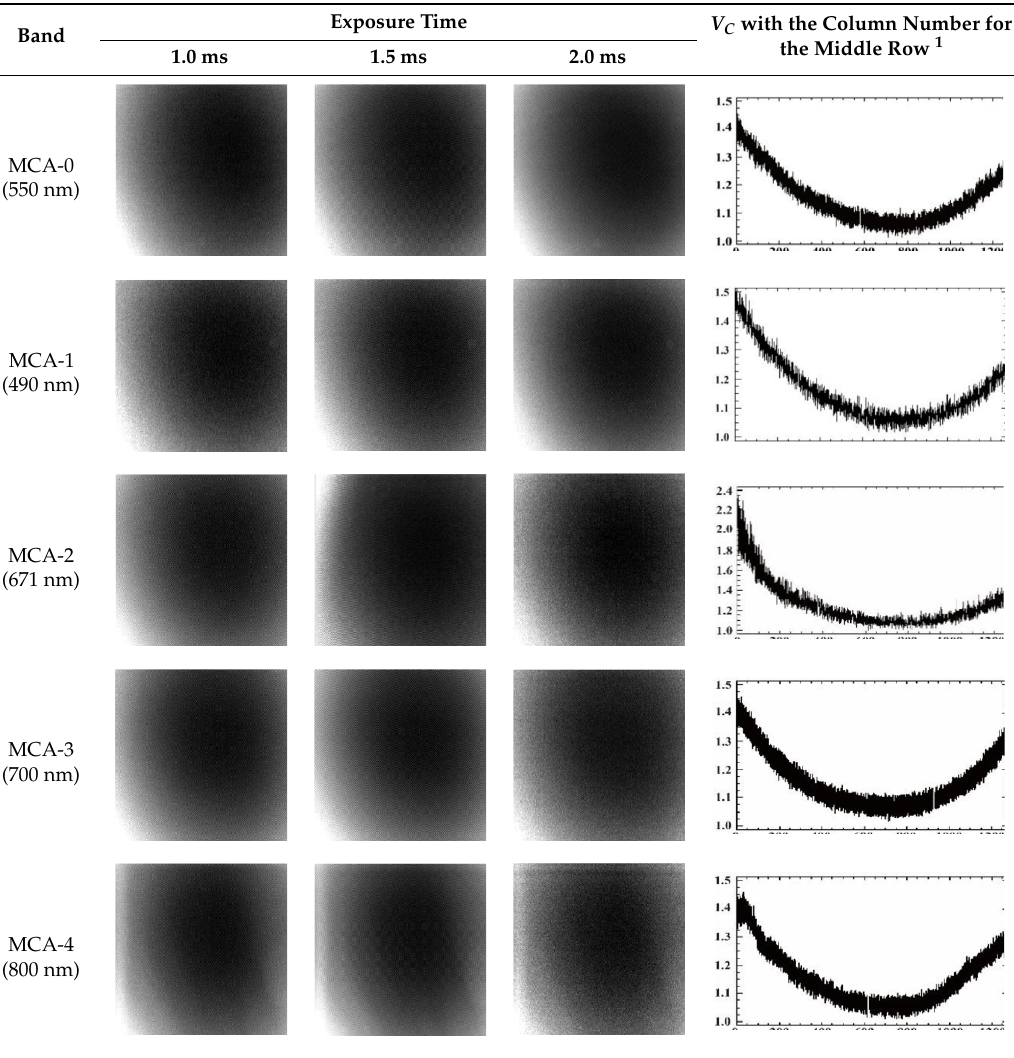
Table 7. The images for the vignetting correction factor ( Vc ) for the five channels of the Mini-MCA6 at different exposure